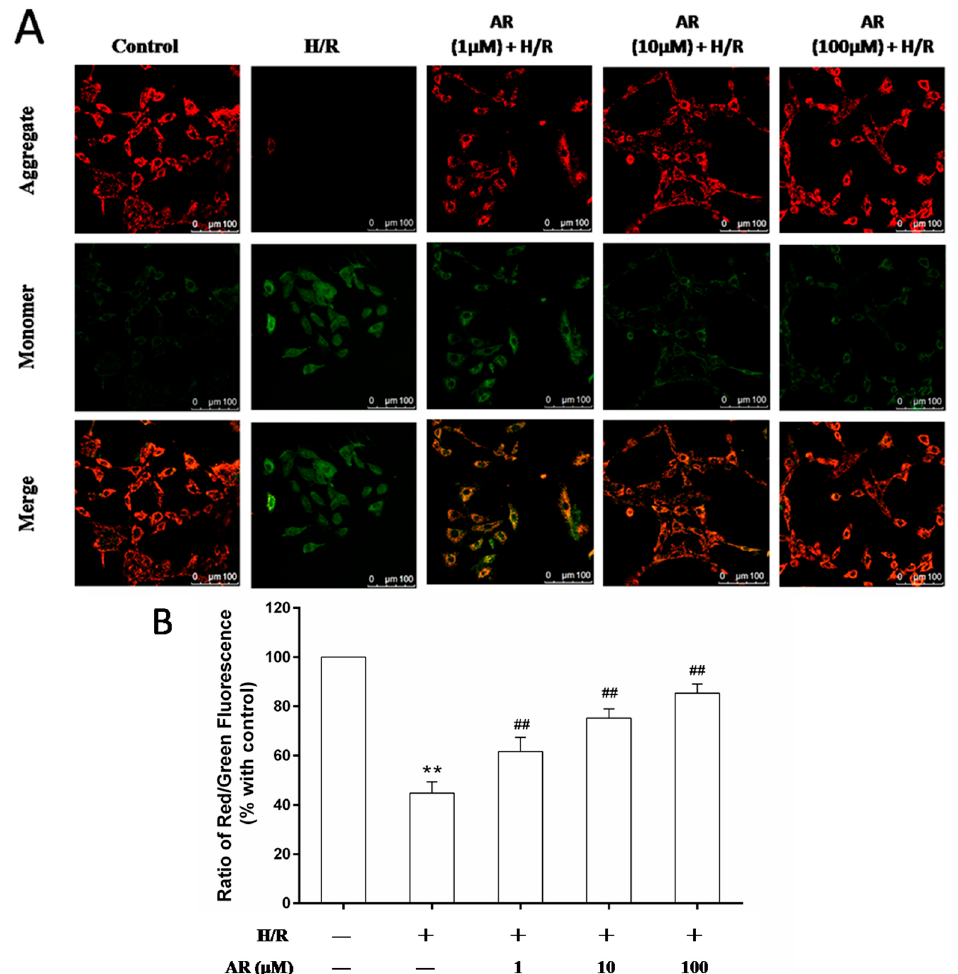
Figure 6. AR pretreatment maintained the ΔΨ m in H/R-injured cells. ΔΨ m of the different groups was estimated with JC-1 probe. For red fluorescent excitation is 585 nm and emission is 590 nm; for green fluorescent excitation is 514 nm and emission is 530 nm. ( A ) JC-1 aggregates red fluorescence in mitochondria of normal cells. JC-1 accrues as green fluorescence monomer in the cytosol of apoptotic cells, which indicates ΔΨ m collapsed. Merged images showed the co-localization of JC-1 aggregates and monomers. Scale bar: 100 μ m; ( B ) The ΔΨ m of cells in different groups was calculated as the fluorescent ratio of red to green. Values are mean ± S.D ( n = 5). **: p < 0.01 vs. control group; ## : p < 0.01 vs. H/R group.